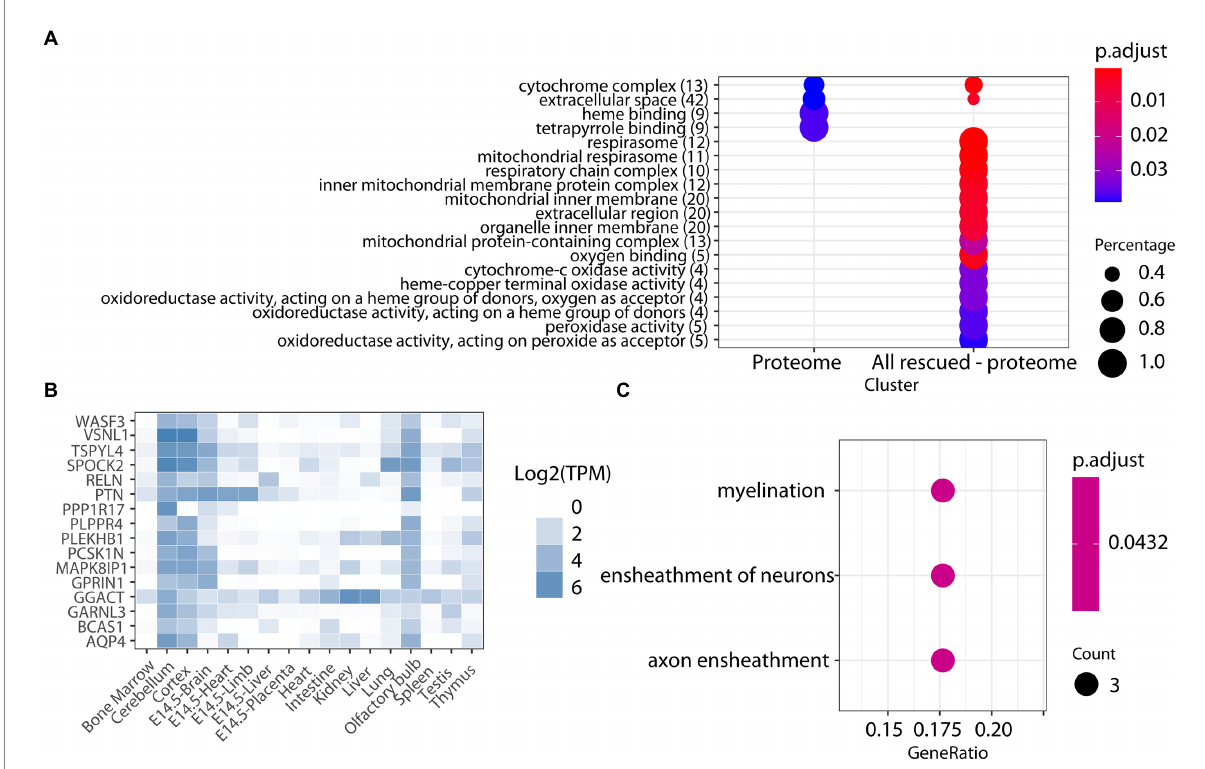
FIGURE 1 (A) Enrichment analysis for biological processes, molecular function, and cell components of proteins altered in the cerebellum of TG mice. The color-gradient indicates the adjusted p -value for the enrichment. Numbers in parentheses indicate the number of identified proteins in each category. Dot size corresponds to “protein count for each group”/“total protein count for each category.” (B) Heatmap showing the expression across tissues (TPM, transcript per million) of the cerebellar proteins found to be differentially abundant in our study, showing their cerebellar enrichment. (C) Enrichment analysis on the cerebellar-enriched proteins using the GO